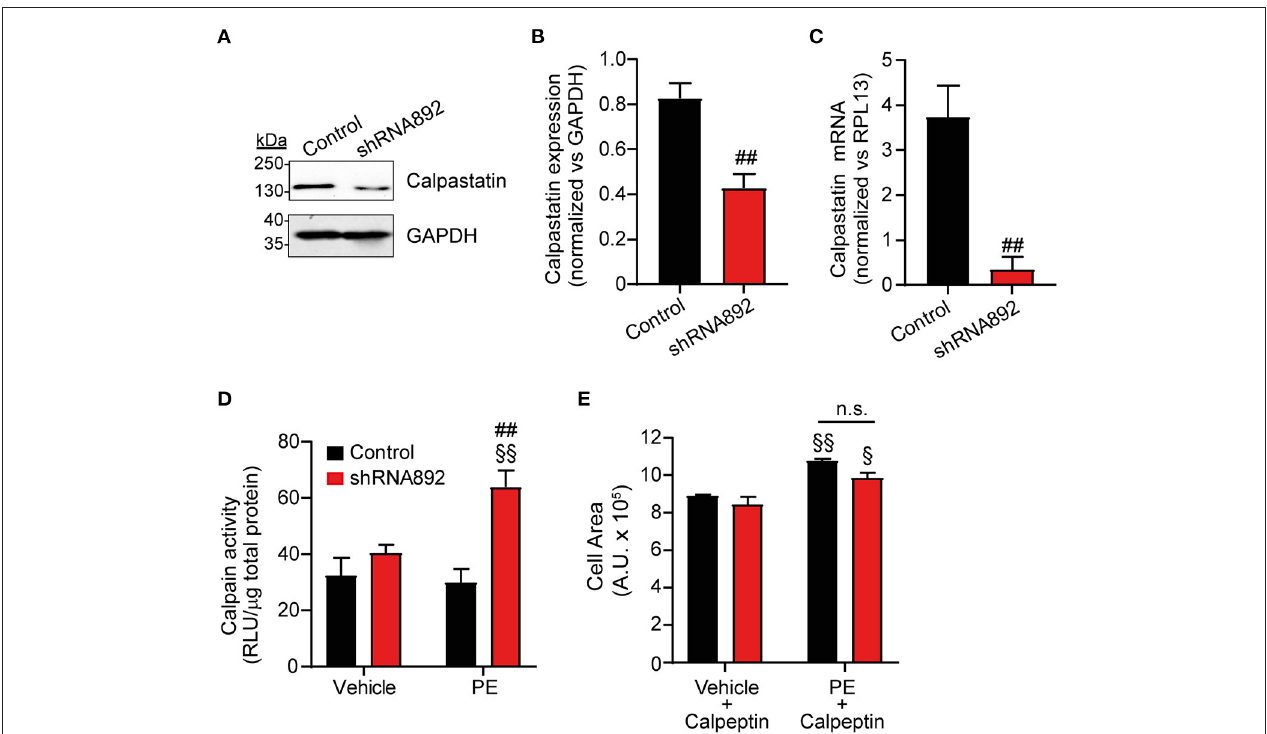
FIGURE 7 | Inhibition of calpain activity abolishes the enhanced PE-induced cardiomyocyte hypertrophy in Ca v β 2 -downregulated NRCs. (A) Representative western blot analysis of calpastatin expression in homogenates from control and Ca v β 2 downregulated NRCs. Per well, 50 µ g of protein were loaded. Anti-GAPDH western blot was used as loading control. (B) Bar plot of calpastatin expression normalized vs. GAPDH in homogenates from control and Ca v β 2 downregulated NRCs. Mean ± SEM of 3 different experiments; ## p < 0.05 (two-tailed unpaired t -test). (C) Bar plot of the qRT-PCR analyses of calpastatin expression in control and Ca v β 2 downregulated NRCs; ## p < 0.05 (two-tailed unpaired t -test). (D) Bar plot of calpain activity analyses of control and Ca v β 2 -downregulated NRCs after the treatment with vehicle or 50 µ M phenylephrine (PE). Mean ± SEM of 6 different experiments; §§ p < 0.05 vs. vehicle-treated cells in the same group; ## p < 0.01 vs. control cells treated similarly (two-way ANOVA with Holm–Sidak’s method). (E) Bar plot of the mean values of the cell area of the control and Ca v β 2 -downregulated NRCs after vehicle and 25 µ M of calpeptin or PE and calpeptin treatments. Mean ± SEM; 150–200 cells per group from 20 randomly chosen fields from 3 replicated experiments were measured; §§ p < 0.01 vs. vehicle and calpeptin-treated cells in the same group; § p < 0.05 vs. vehicle and calpeptin-treated cells in the same group; n.s. non-significant (two-way ANOVA with Holm–Sidak’s